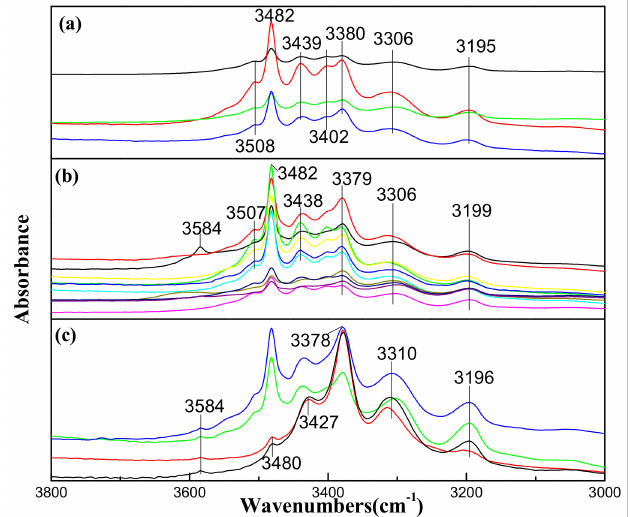
Figure 2. IR spectra of synthetic rock crystal samples (Group I) unheated and after heating at different temperatures. ( a ) IR spectra of unheated SQ − 5 − a~SQ − 5 − d; ( b ) IR spectra of SQ − 3 − a~SQ − 3 − d and SQ − 4 − a~SQ − 4 − d after heating at 673 K (since SQ − 3 − b and SQ − 3 − c were broken into two pieces, two more spectral lines were collected); ( c ) IR spectra of SQ − 1 − a~SQ − 1 − d after heating at 1073